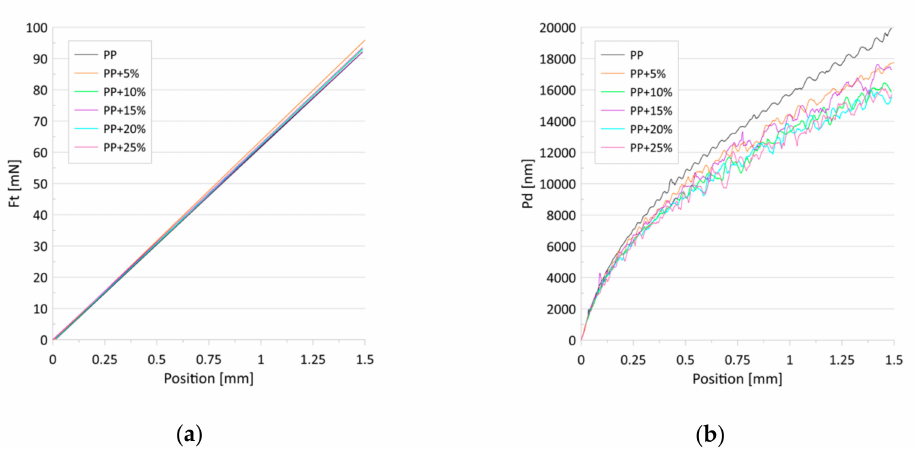
Figure 7. ( a ) The approximated dependence of the friction force (Ft) on the scratch positions for the tested samples; ( b ) The average dependence of the penetration depths (Pd) on the scratch positions for the tested samples. Progressive-load scratch tests were performed for loads from 0.2 to 100